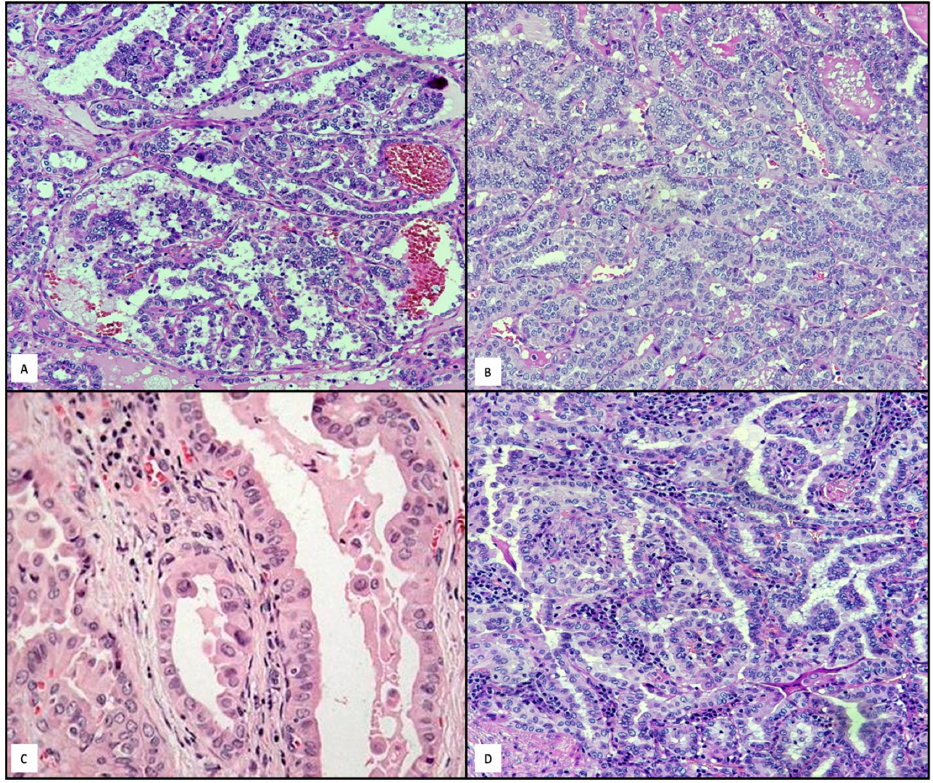
Figure 5. A gallery of some relevant variants of PTC: classical (( A ), hematoxylin and eosin, 120×); follicular (( B ), hematoxylin and eosin, 120×); Whartin-like (( C ), hematoxylin and eosin, 120×); micropapillary (( D ), hematoxylin and eosin, 160×).